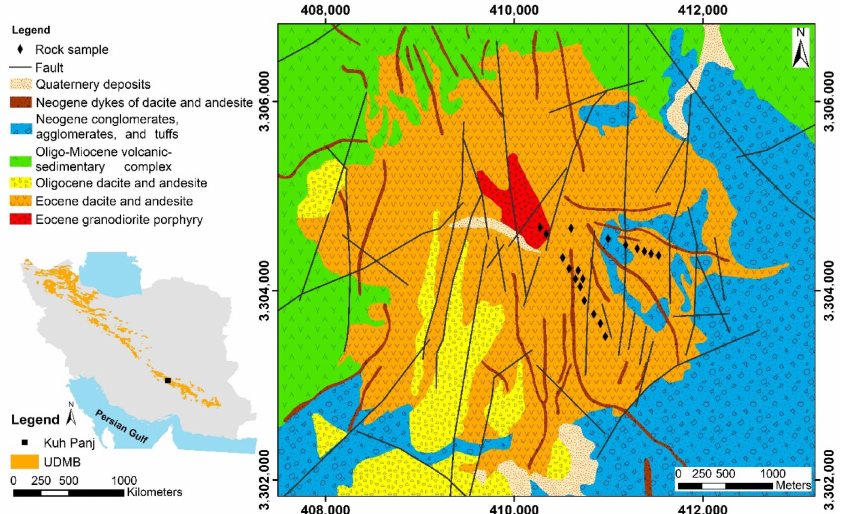
Figure 1. Location of the Kuh Panj area (solid black square) within the UDMB (orange) and location of rock samples (solid black diamond) in 1:20,000 geological map of the Kuh Panj area (modified from